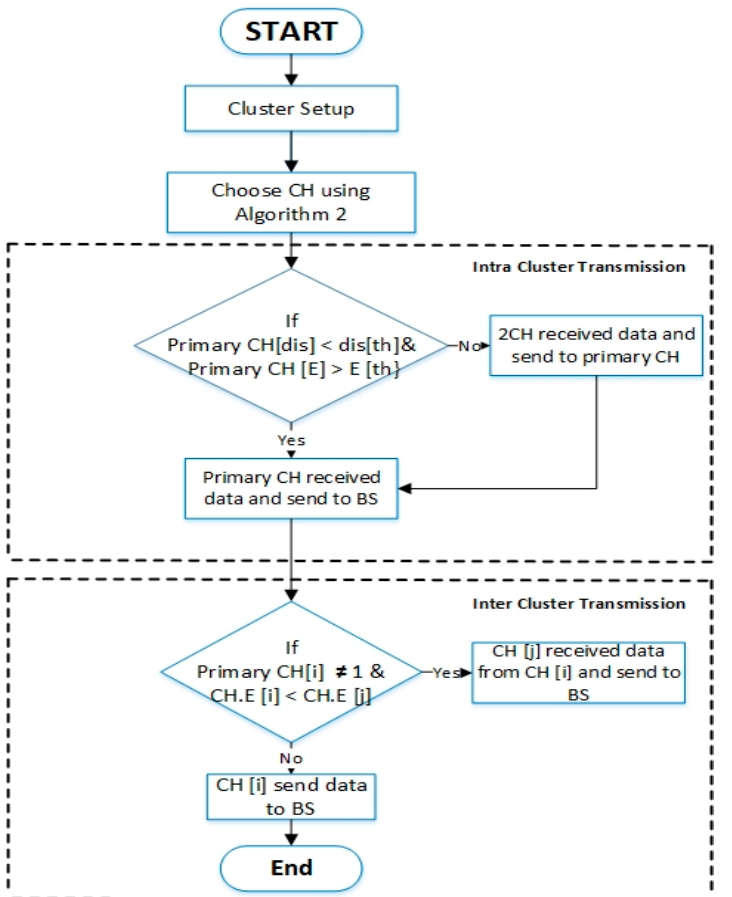
Figure 10. The flowchart of the main CH rotation strategy.